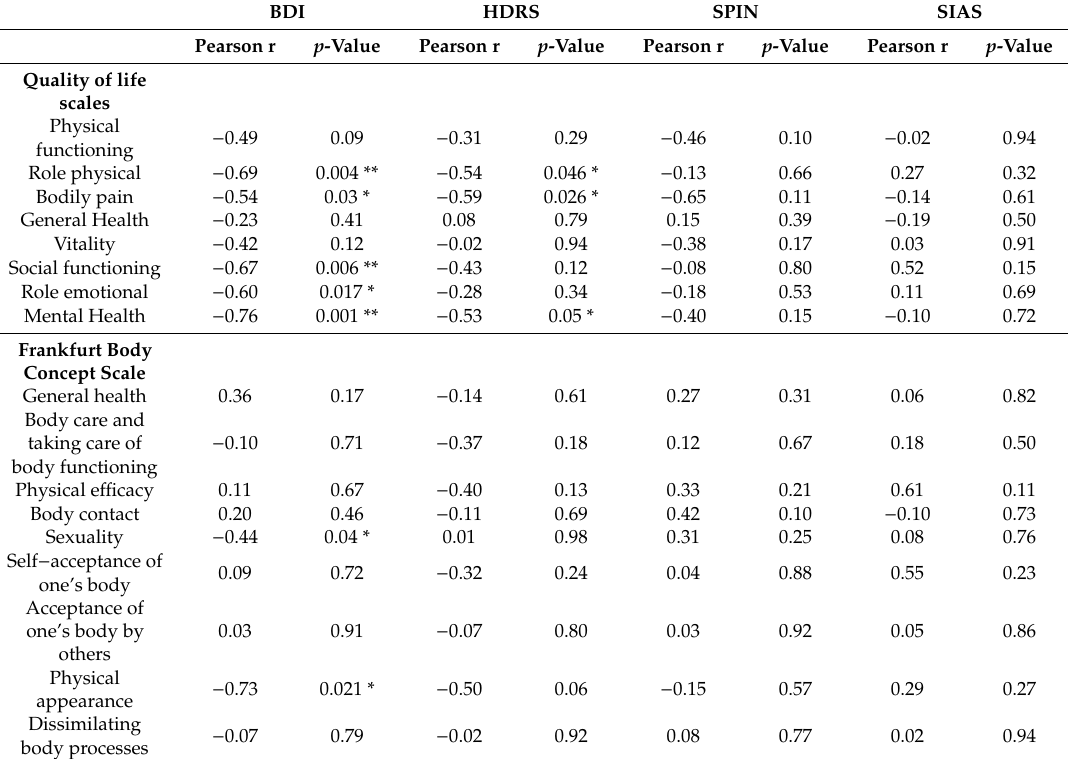
Table 2. Correlations of depression (Beck Depression Inventory—BDI, Hamilton Depression Rating Scale—HDRS) and social anxiety scales (Social Phobia Inventory—SPIN, Social Phobia Interaction Anxiety Scale—SIAS) with quality of life (SF-36) and the Frankfurt Body Concept Scale